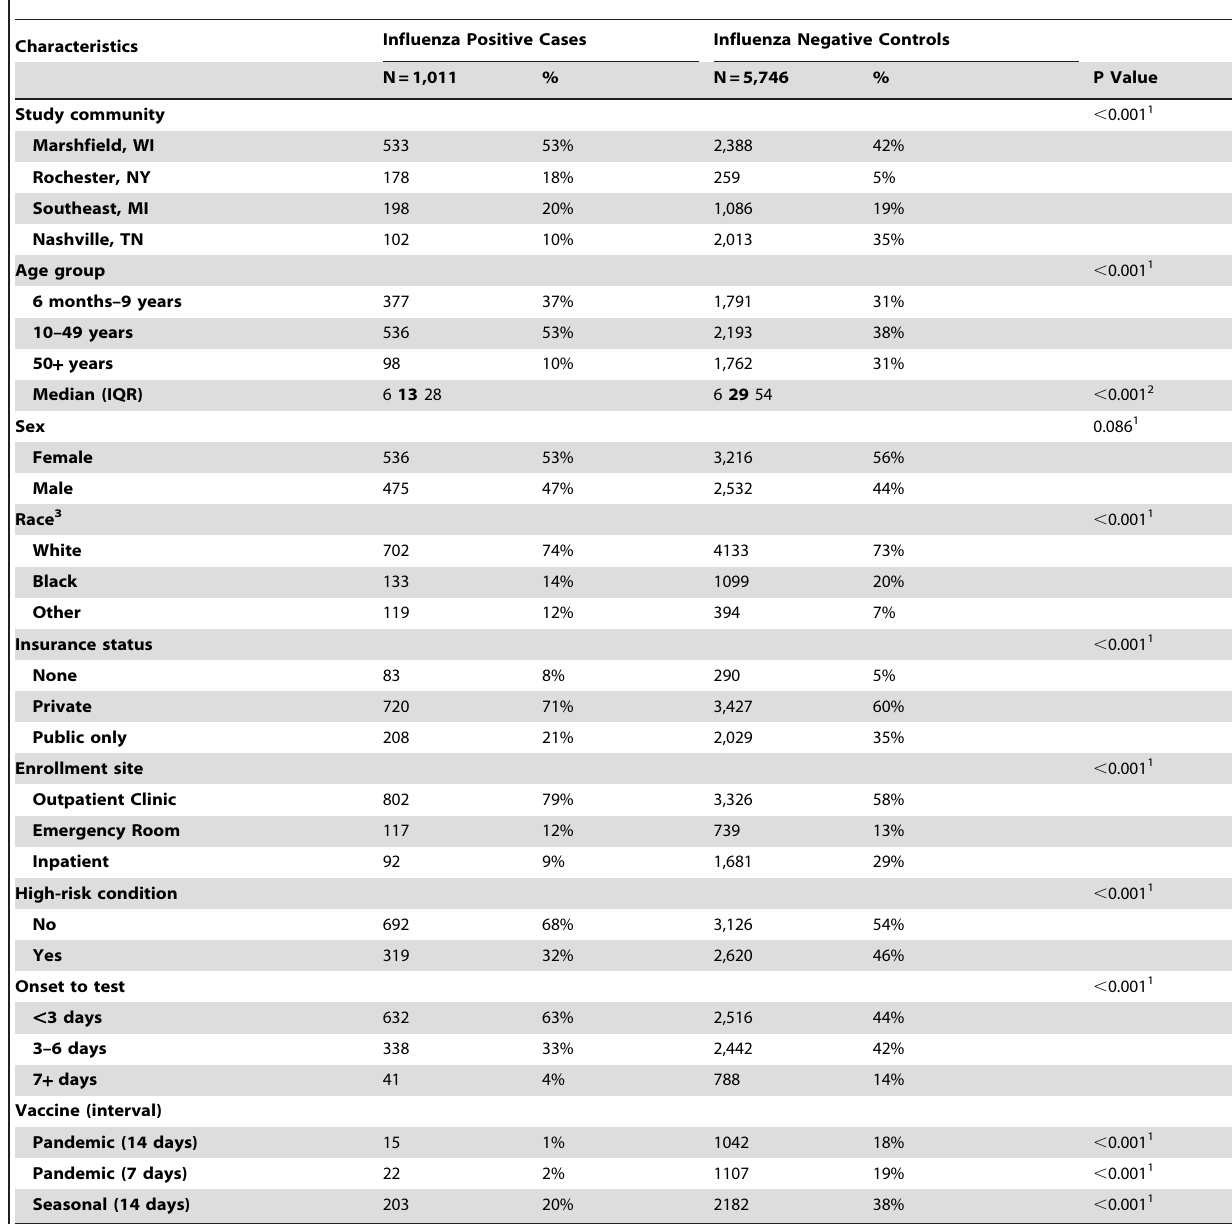
Table 1. Descriptive Characteristics of Enrolled Patients with Medically Attended Acute Respiratory Illness by Case Control Status.